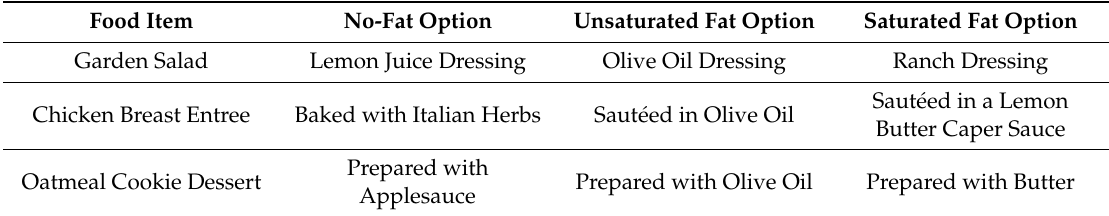
Table 1. Faith in fat food item and di ff ering fat options for preparation